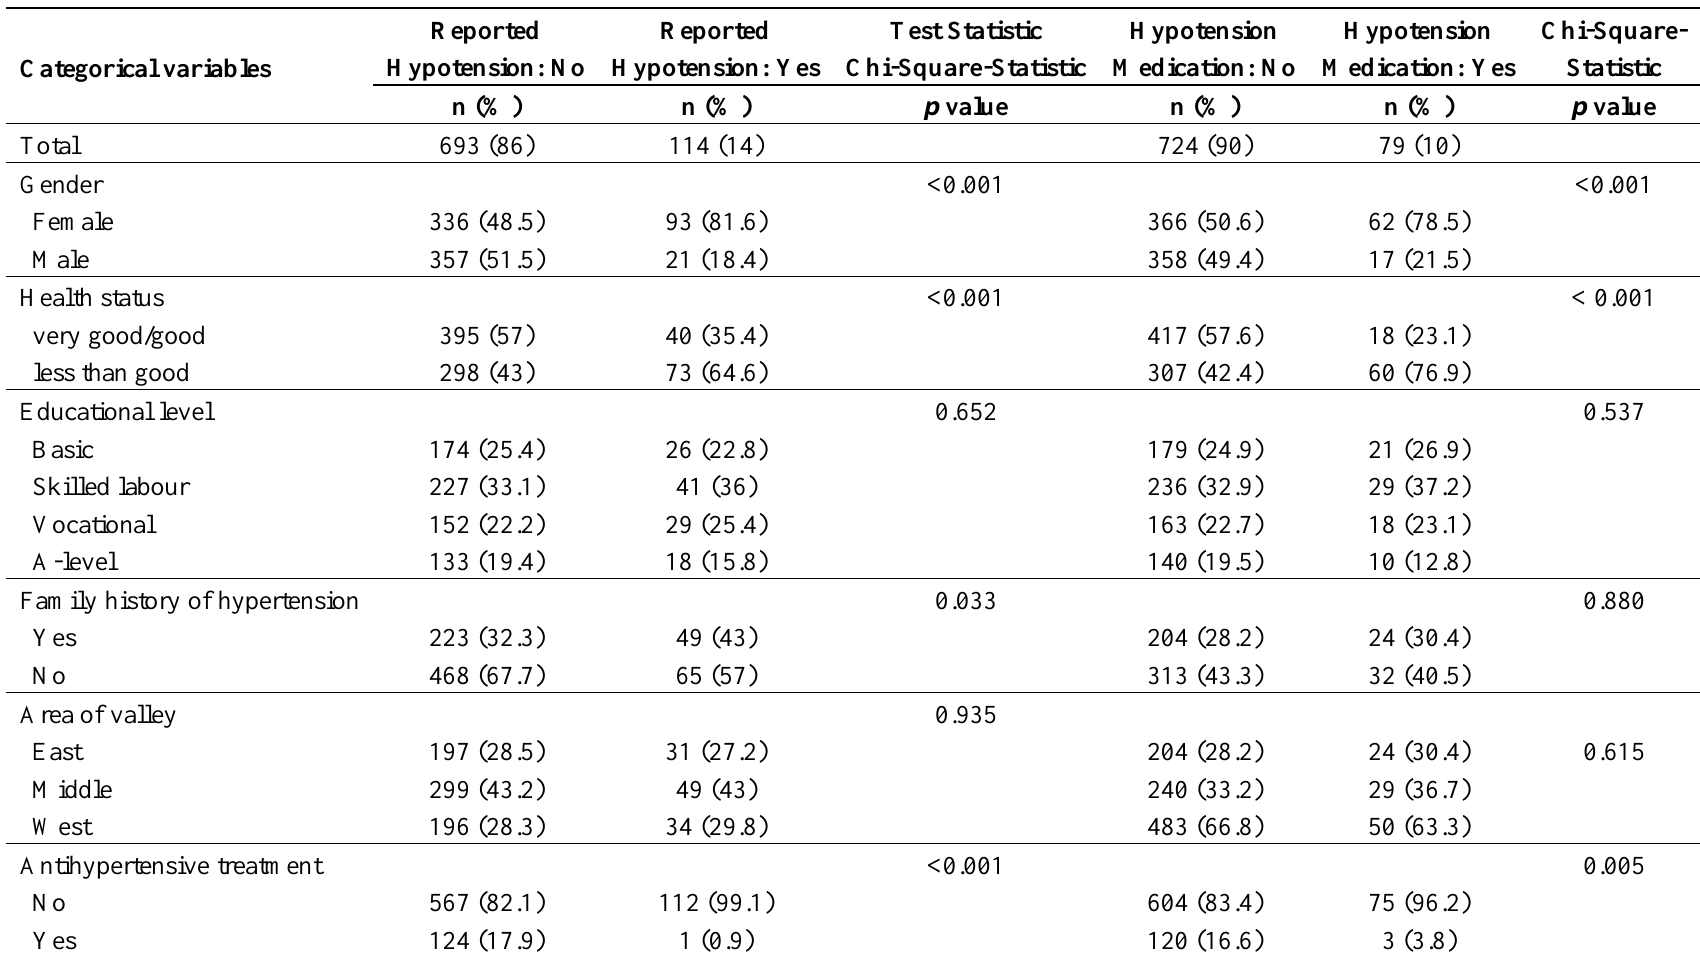
Table 1. Description of the relationships between main study variables and the two health outcomes (full sample). Reported Reported Test Statistic Hypotension Hypotension Chi-Square- Hypotension: No Hypotension: Yes Chi-Square-Statistic Medication: No Medication: Yes Categorical variables